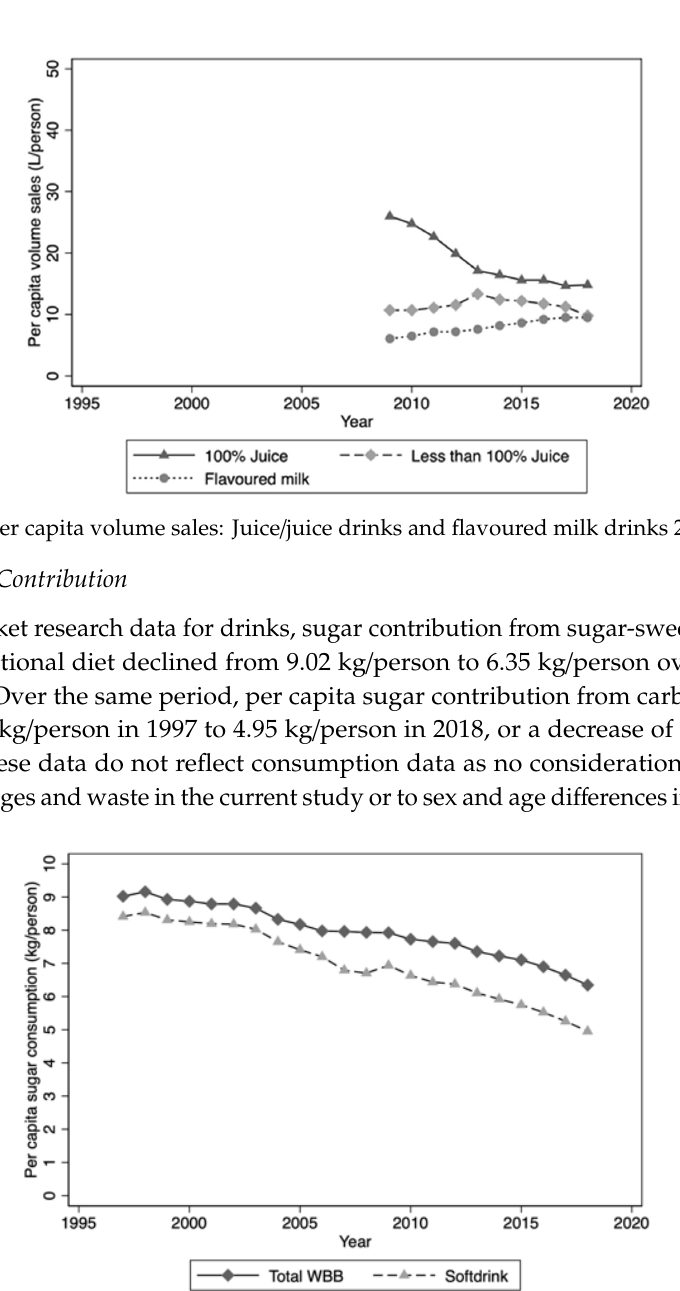
Figure 3. Per capita volume sales: Juice/juice drinks and flavoured milk drinks 2009–2018.